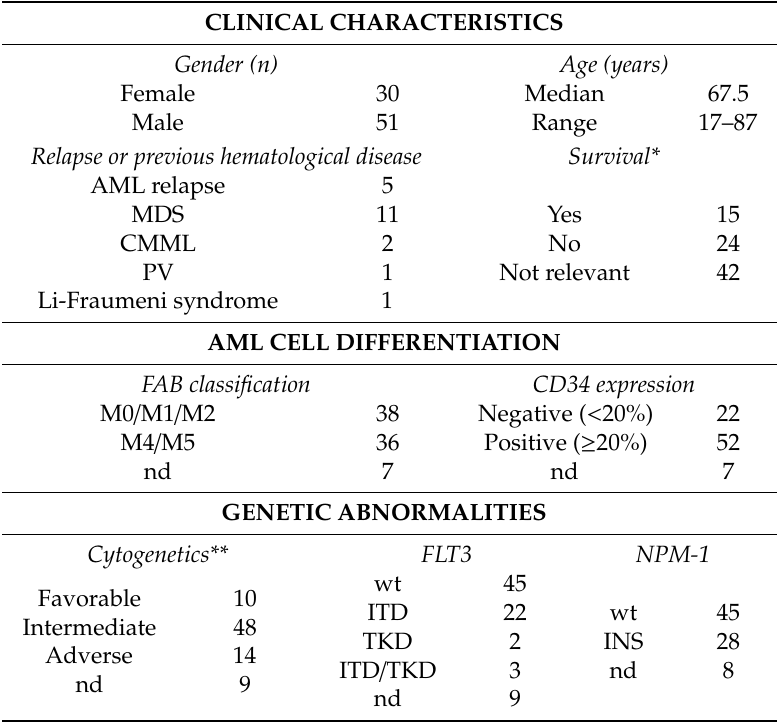
Table 1. Biological and clinical features of the 81 AML patients in this